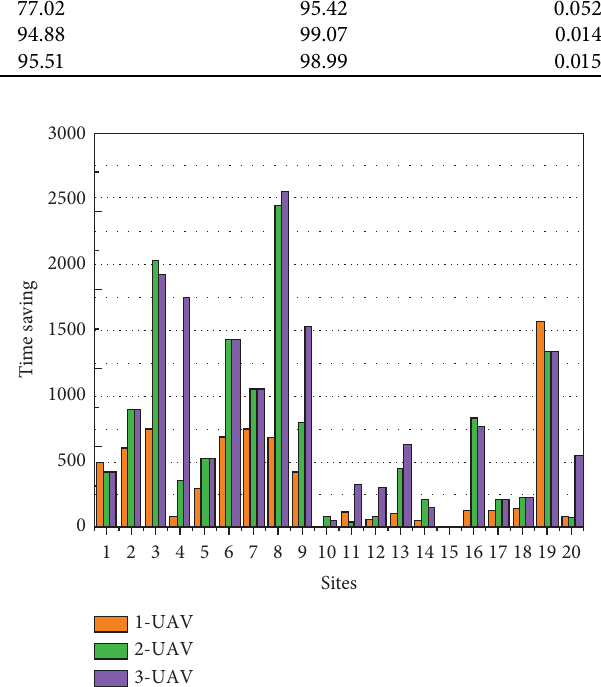
Figure 7: Time saved by drones based on heuristics.